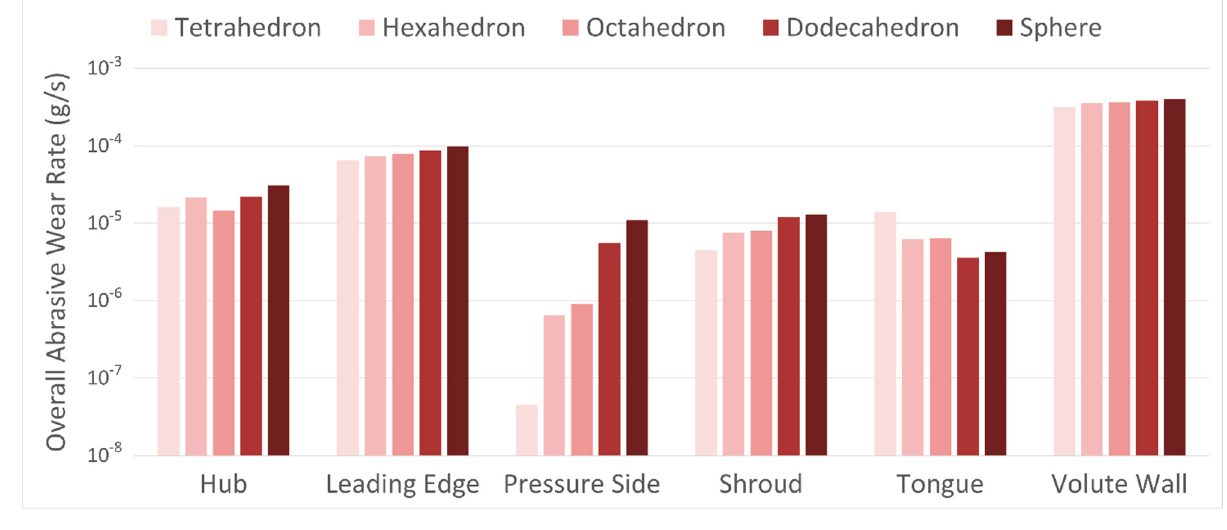
Figure 10. Overall impact wear rate of flow parts.